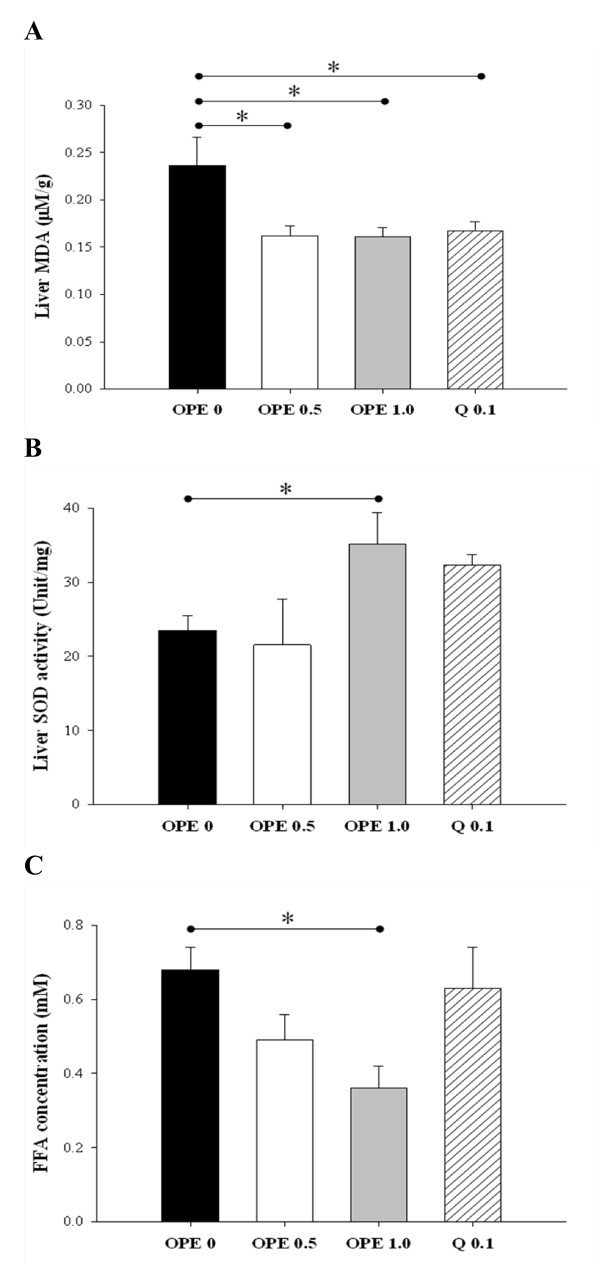
Effect of OPE or quercetin on MDA formation (A), SOD activity (B), and plasma FFAs (C) in HFD/STZ-induced diabetic rats. MDA formation, SOD activity and plasma FFAs were measured in liver and skeletal muscle after 8 week administrations of 0, 0.5, 1% OPE or 0.1% quercetin in HFD/STZ-induced diabetic rats. Data are expressed as means ± SE (n = 7 for each group). Comparisons were done between the control group and each individual treated group by Dunnet's multiple comparison test. * Different from control, P < 0.05